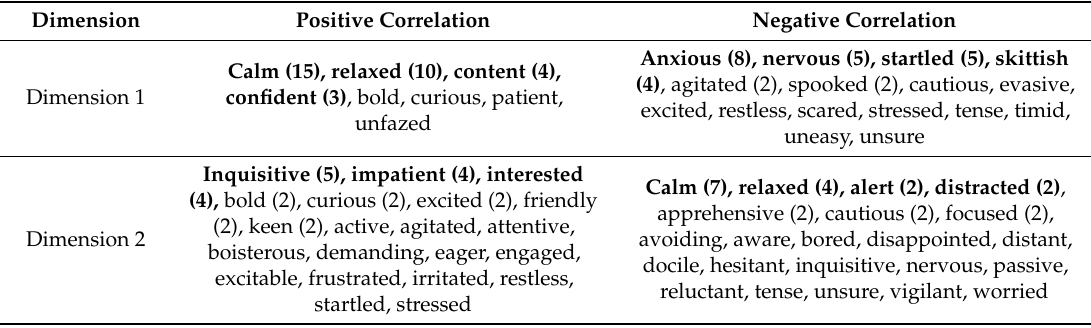
Table 4. Terms showing the highest positive and negative correlations with qualitative behavior assessment (QBA) dimensions 1 and 2 (two per observer). Figures in brackets give the number of observers using that term. Terms highlighted in bold were used to determine dimension labels.